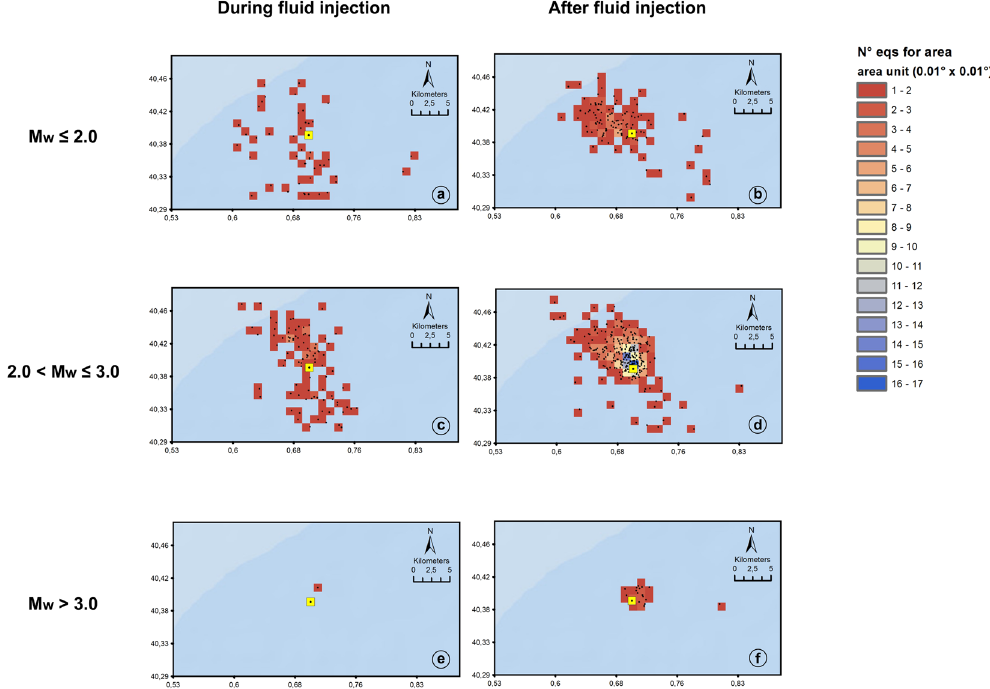
Figure 8. Number of earthquakes for area unit during ( a , c , e ) and after ( b , d , f ) the fluid injection. The area unit is 0.01 × 0.01 decimal degrees. The earthquakes are showed with black points and are divided in magnitude classes. ( a ) and ( b ) correspond to M w 2.0 ( c ) and ( d ) correspond to M w between 2.0 and 3.0. ( e ) and ( f ) correspond to M w greater than 3.0. The Castor platform is indicated by yellow square. The figure was generated by using the ESRI software, ArcGIS for desktop, version 10.1.